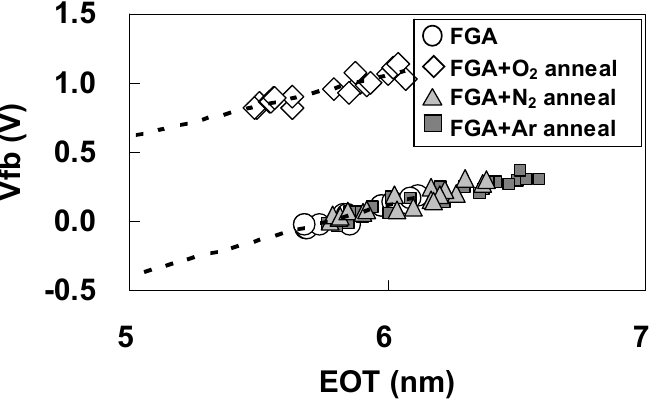
and Ar annealing. The curves 2 annealing are shown again for 2